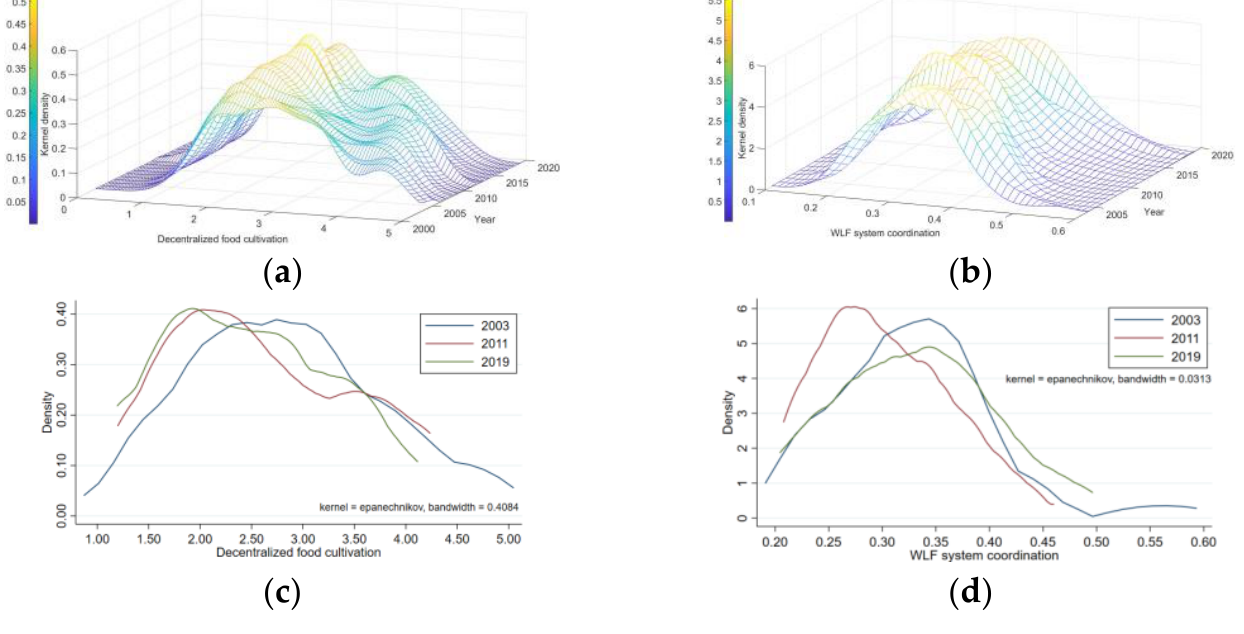
Figure 2. Kernel density estimation of decentralized food crop cultivation and WLF nexus, 2003 – 2019. ( a ) 2003 – 2019 decentralized food crop cultivation; ( b ) 2003 – 2019 WLF nexus; ( c ) Individual years of decentralized food crop cultivation; ( d ) Individual years of WLF nexus.